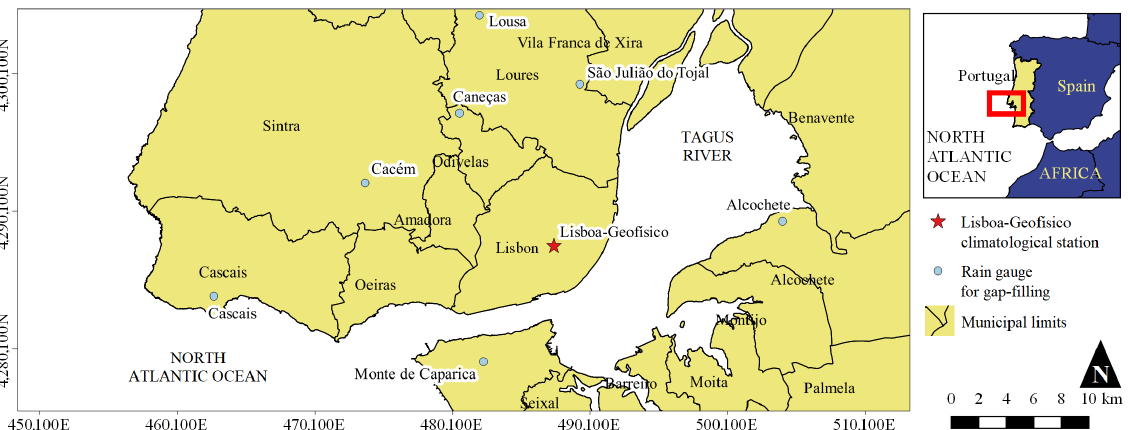
Figure 1. The Lisbon Metropolitan Area. Location of the Lisboa-Geofísico climatological station, and the rain gauges used for gap-filling. Coordinate referencing system: WGSM84, UTM zone 29 N. The Lisboa-Geofísico climatological station (29U 487481.65 m E 4287553.88 m N, 77